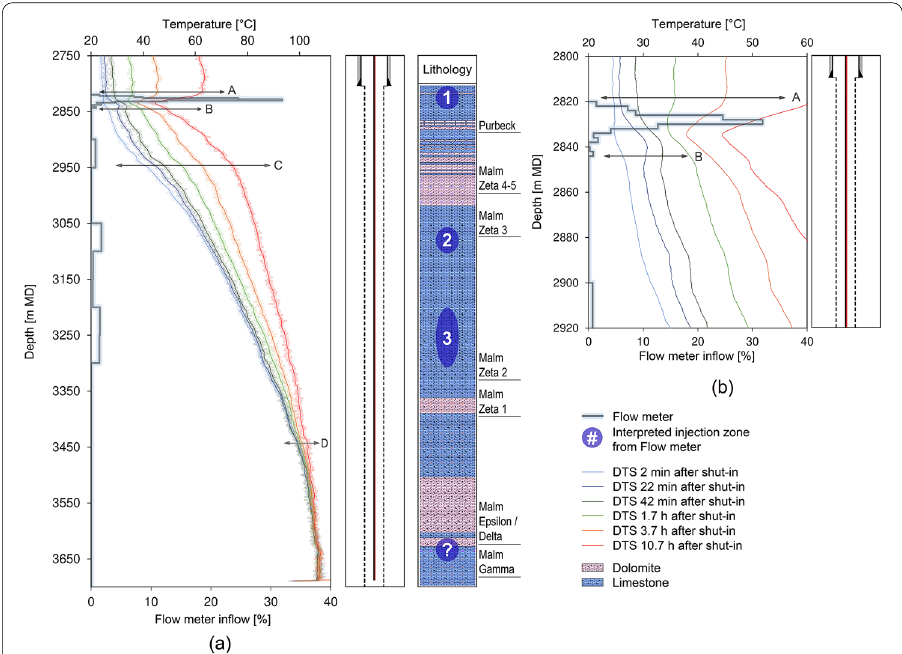
Fig. 15 Comparison of DTS warm-back profiles and flowmeter injection profile with interpreted injection zones from flowmeter interpretation. Transparent lines are raw DTS data, sharp lines are moving average over 10 m. a Six DTS profiles taken at different times during the first 11 h together with flowmeter inflow profile. A, B, C and D mark gradient change of DTS profiles. b Zoom to the top reservoir